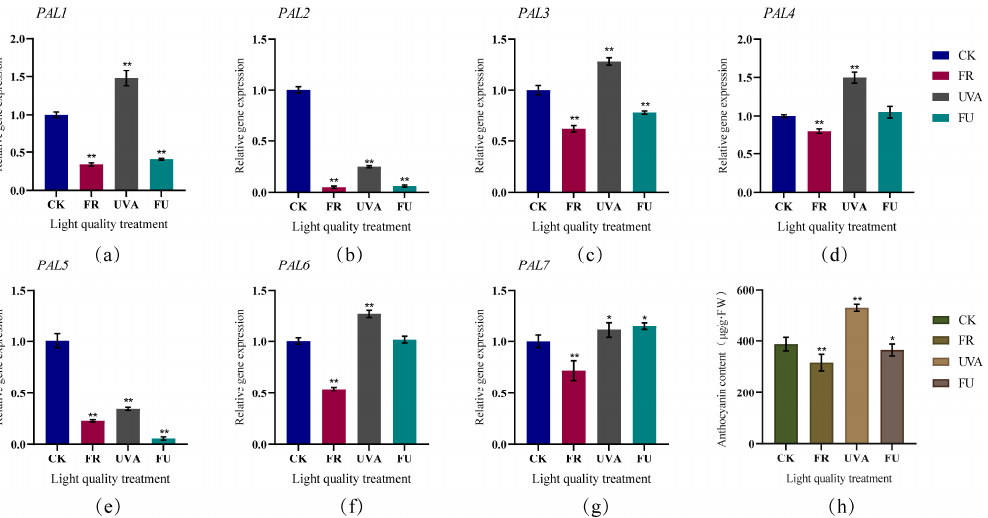
Figure 7. The relative expression level and anthocyanin content of BrPAL gene under light quality treatment. ( a – g ) Histogram of relative expression of PAL gene in purple cabbage under light quality treatment; ( h ) Histogram of anthocyanin content in purple cabbage under light quality treatment. Data represent the mean of triplicate with three biological replicates. * indicates significance ( p < 0.05); ** indicates extremely significant difference ( p < 0.01).